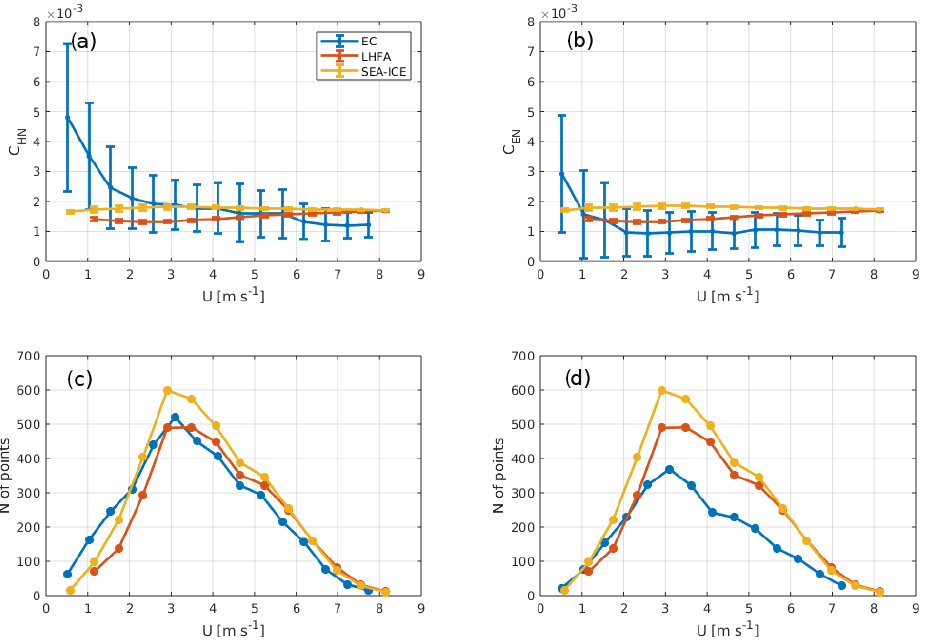
Figure 11. Dependency of neutral transfer coefficients ( − 0 . 1 < zL − 1 < 0 . 1) as a function of wind speed. Panels (a) and (b) show this dependency for heat ( C HN ) and evaporation ( C EN ), as estimated from models (LHFA and SEA-ICE) and EC observations (EC), respectively. The error bars indicate the standard deviation in the bins. Panels (c) and (d) show the distribution of neutral conditions as a function of wind speed. C HN data were filtered for small temperature differences ( | T 0 − T a | < 0 . 5K), and C EN data were filtered for very small and negative values of the humidity difference ( q 0 − q a < 2 × 10 − 4 kgkg − 1 ). The 30min values of coefficients were also not included in case of very low wind speed ( U < 0 . 5ms − 1 ). Bins with fewer than 10 values were not included. The values are for the measurement height of 1.8m. Table 4. Neutral ( − 0 . 1 ≤ zL − 1 ≤ 0 . 1) transfer coefficients estimated at z = 1 . 8m. Model/ Transfer Transfer coefficient Transfer coefficient